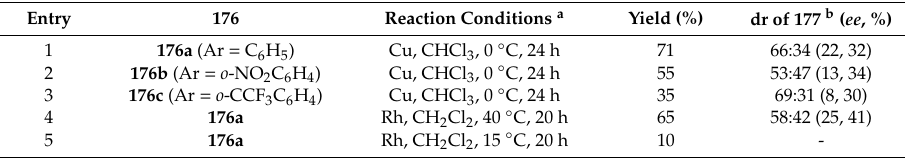
Table 14. Reaction conditions for Scheme 46: Cu: CuOTf (5 mol%) + bisoxazoline (5 mol%); ii, cat. Rh: